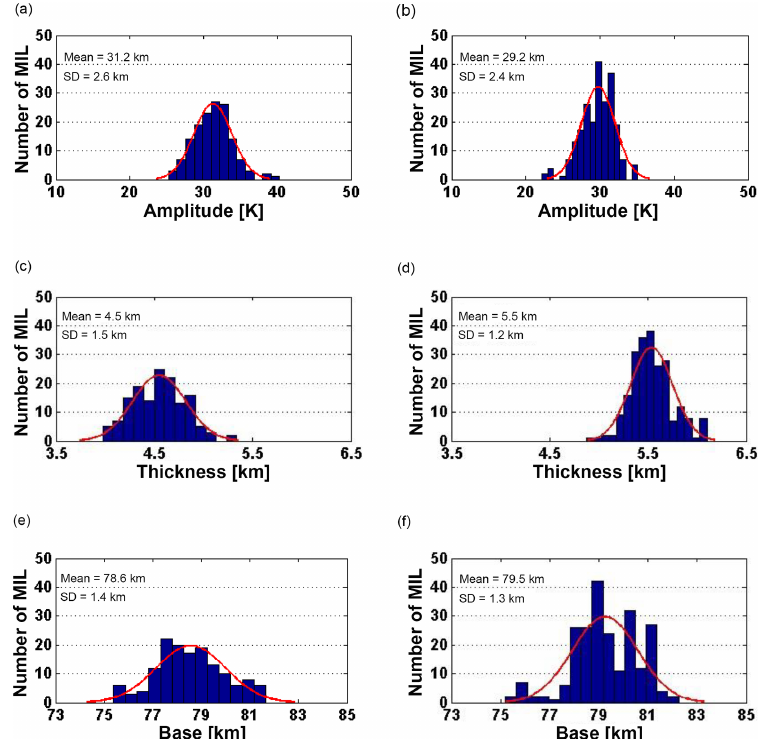
Figure 3. Distribution of MIL (a, b) amplitude, (c, d) thickness and (e, f) base over Réunion (a, c, e) and Mauna Loa (b, d, f) from lidar observations during the 1994–2009 period and the 1994–2014 period,